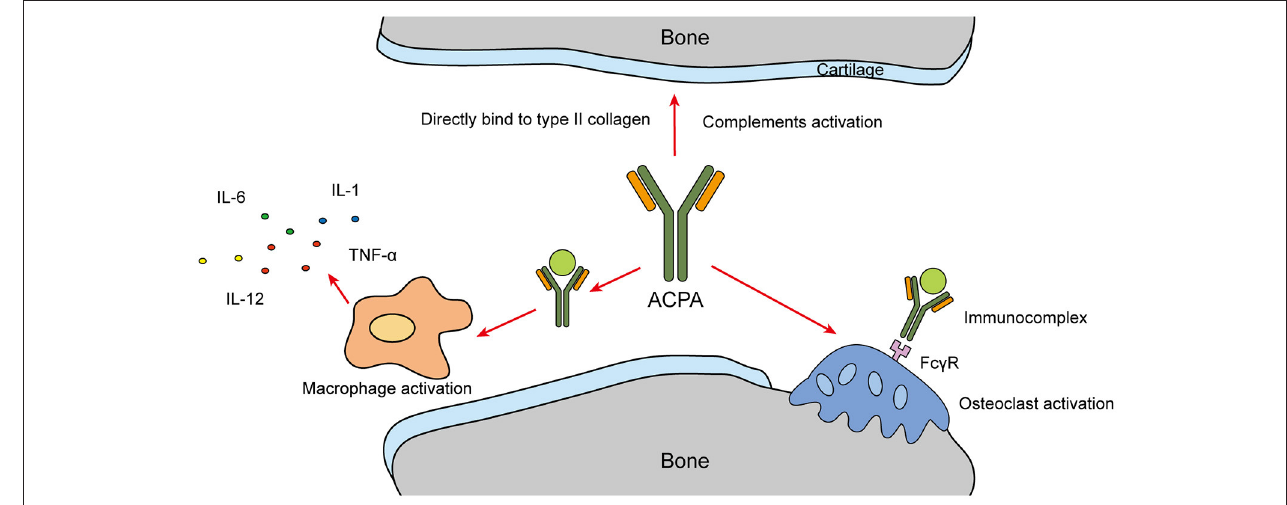
FIGURE 3 | ACPA bone destruction.